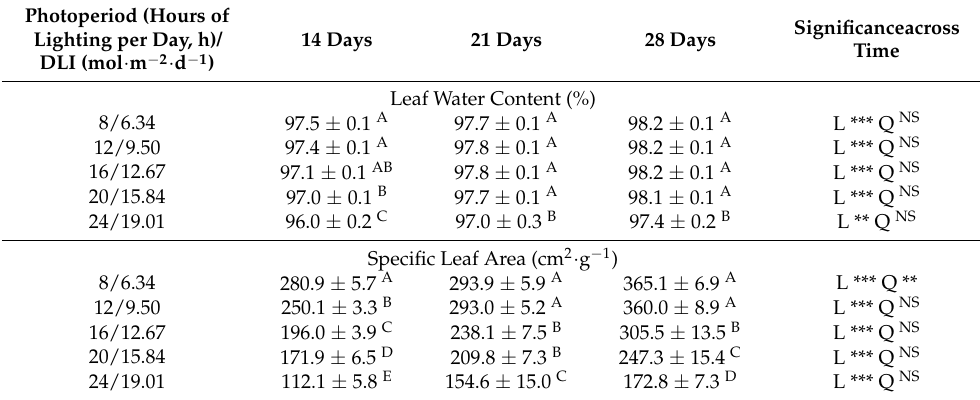
Table 4. Mean leaf water content and specific leaf area of ice plant in response to photoperiod/daily light integral (DLI) treatment over time (plants harvested 14, 21, or 28 days after treatment). Data represent means ( ± SE) of 3 experimental units times 3 replications over